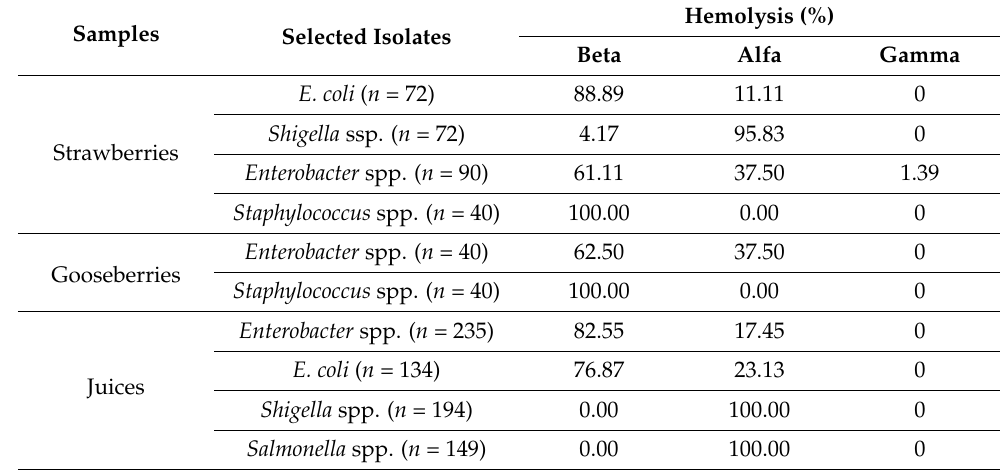
Table 4. Hemolytic pattern (%) of the selected isolates originated from fruits and